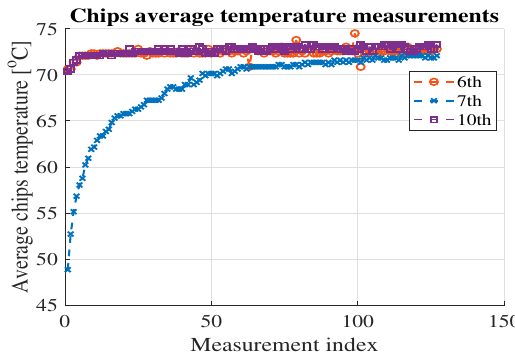
Figure 5. Chips average temperature measurements.